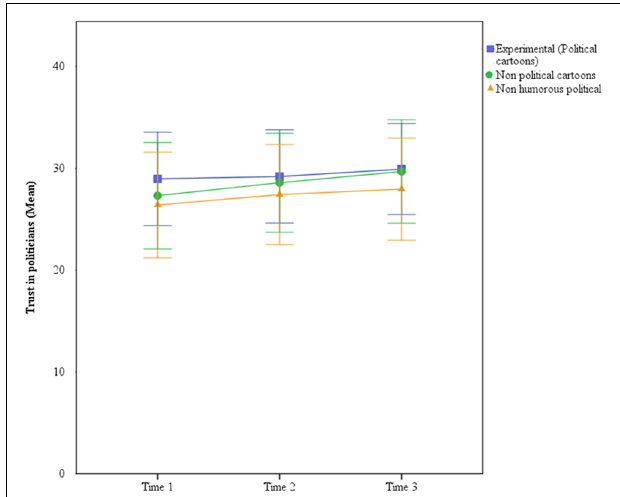
FIGURE 3 | Trust in politicians at times 1, 2, and 3 (Study 2).